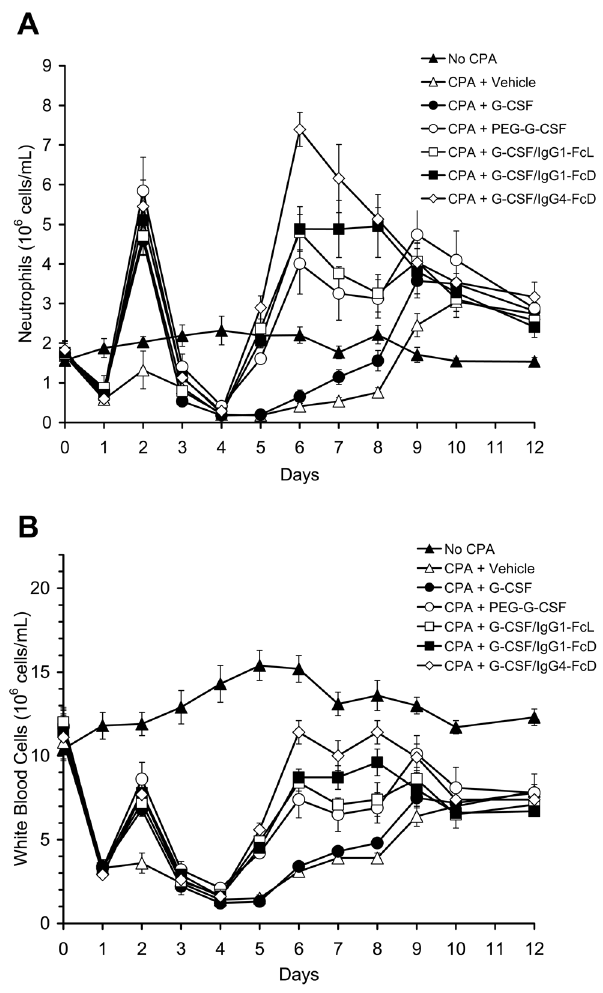
Figure 4. Changes in neutrophil and white blood cell counts in neutropenic rats treated once with G-CSF/IgG-Fc proteins. Rats were made neutropenic by injection of CPA on Day 0. On Day 1 different groups of rats received injections of G-CSF (100 m g/kg), PEG-G- CSF (100 m g/kg), G-CSF/IgG1-FcL (100 m g/kg), G-CSF/IgG1-FcD (100 m g/kg), G-CSF/IgG4-FcD (100 m g/kg), or vehicle solution. The No CPA control group did not receive CPA but did receive an injection of vehicle solution on Day 1. Blood samples were obtained from the rats on the days indicated and neutrophil ( Panel A ) and white blood cell ( Panel B ) levels measured. Data are means 6 SE for 5